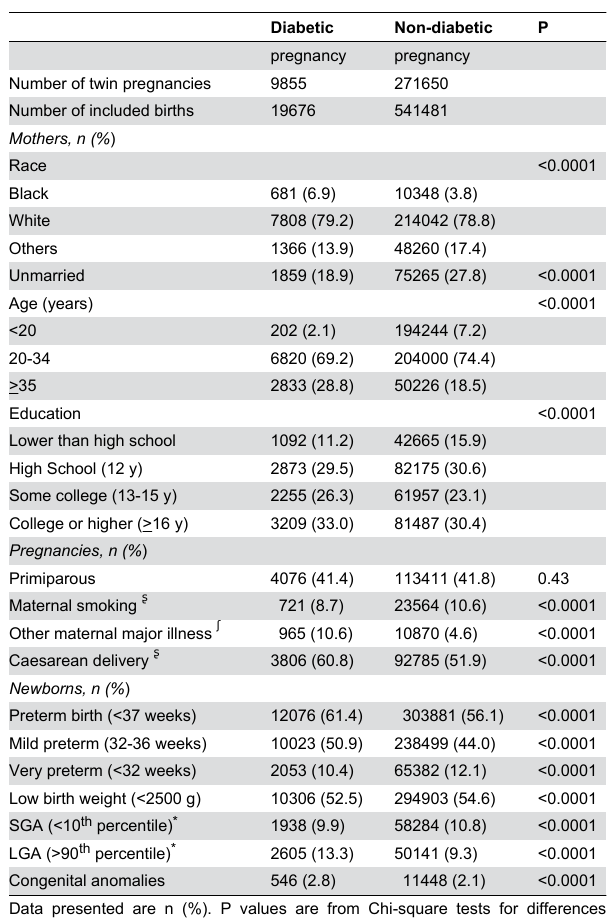
Table 1. Maternal, pregnancy and newborn characteristics in diabetic versus non-diabetic twin pregnancies in the study population, U.S. 1995-2000 [16]. twins. The lower risk of perinatal death in diabetic Diabetic Non-diabetic P